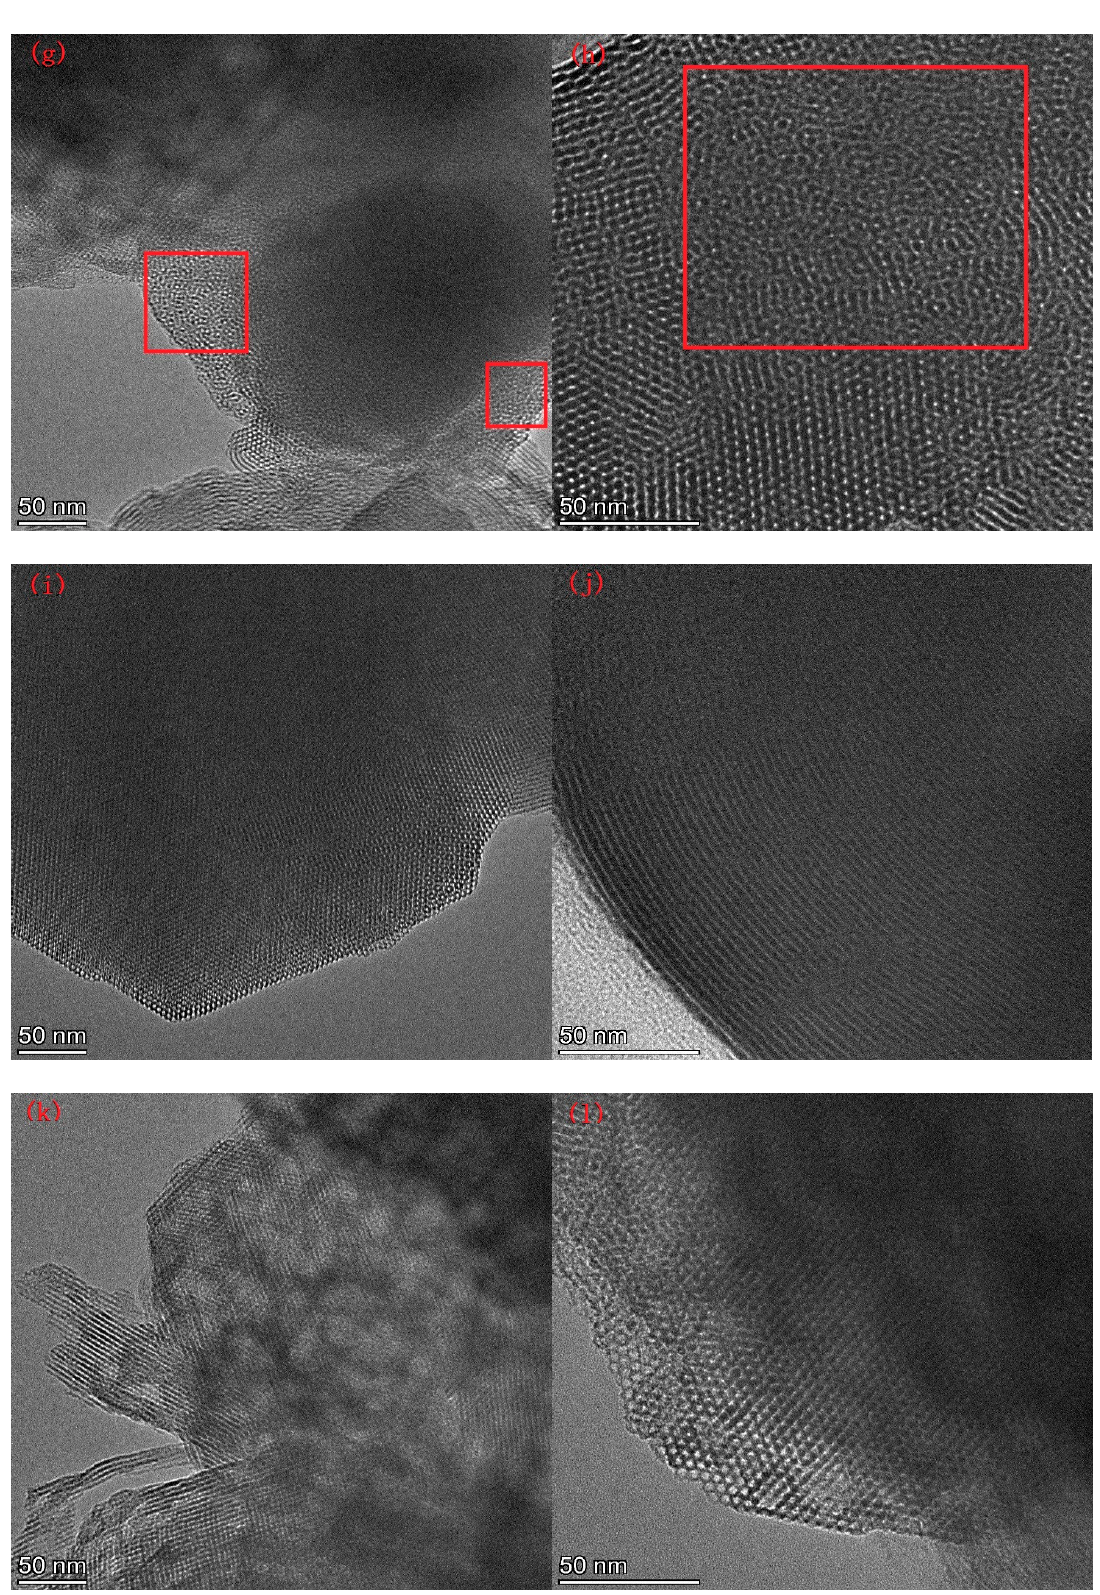
Figure 7. SEM images for ( a , b ) AM41E-120-48, ( c , d ) AM41E-90-48, ( e , f ) AM41E-60-48, ( g , h ) AM41E-30-48, ( i , j ) AM41E-120-72, and ( k , l ) AM41E-120-24.